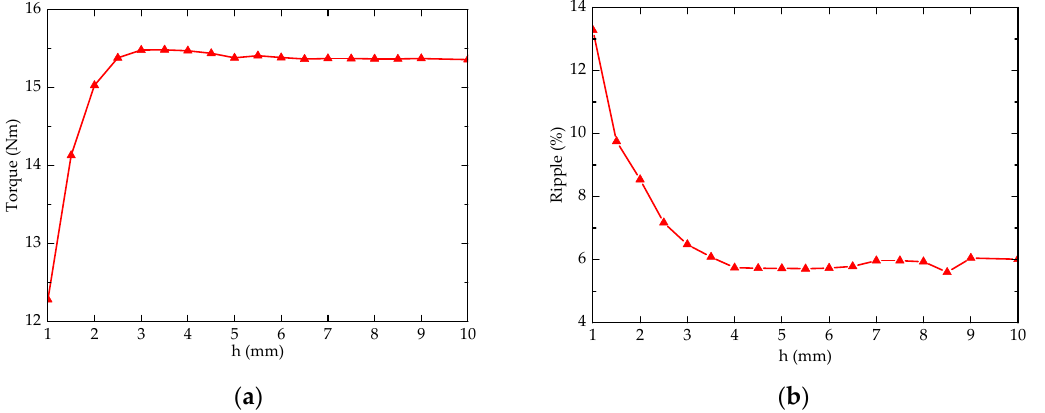
Figure 3. The results of parameterization: ( a ) relationship between average torque and h; ( b ) relationship between torque ripple and h. Table 1. Design parameters of two FSPM machines.